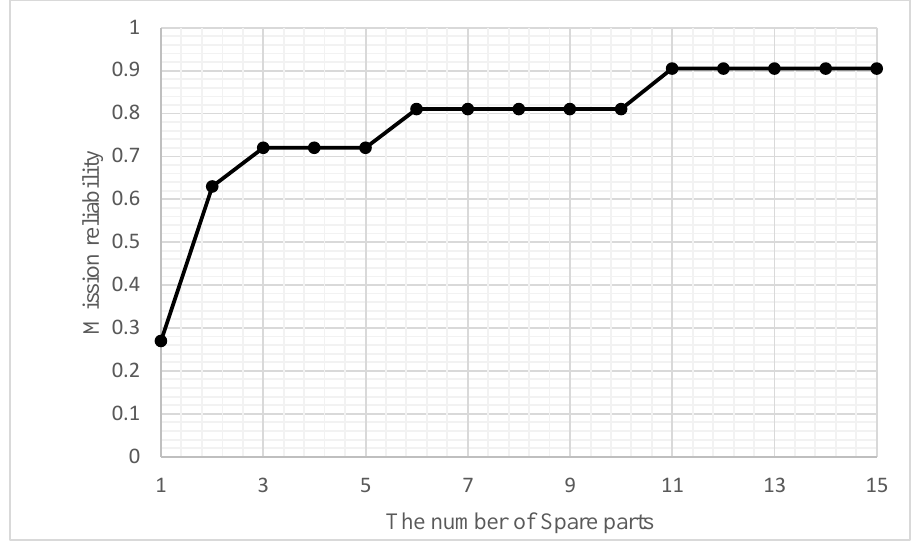
Figure 20. Influence of spare part number on mission reliability (long-time task).